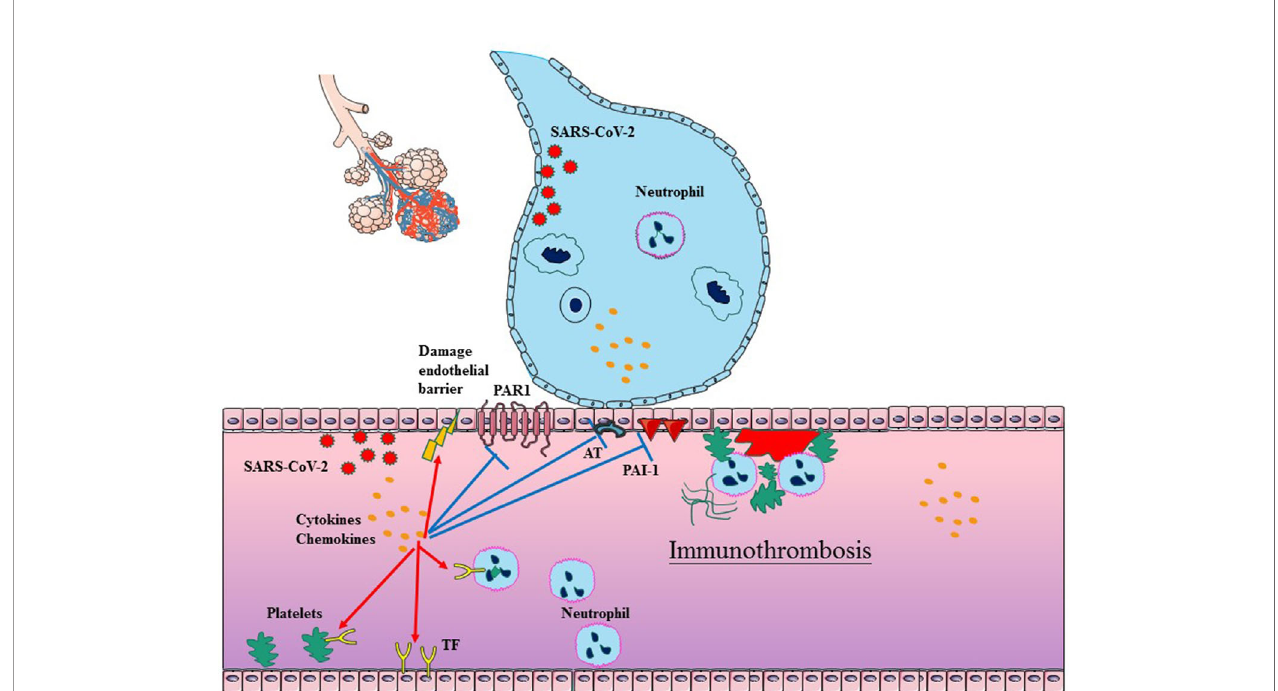
FIGURE 1 | Schematic diagram of immunothrombosis in COVID-19. SARS-CoV-2 infection typically begins in epithelial cells of the respiratory tract, which can further promote the cytokine storm and in fi ltration of neutrophil. The cytokine storm can result in endothelial dysfunction, tissue factor (TF) overexpression, and the platelets activation, which initiates the TF-dependent coagulation process. The release of NETs promotes platelet – neutrophil aggregation and neutrophil activation in the bloodstream. Furthermore, the cytokine storm also suppresses antithrombin, APC and PAI-1, which impair anticoagulation and decrease fi brinolysis. In addition, SARS-CoV-2 can also directly impair ECs. The above factors collectively facilitate the generation of thrombus in